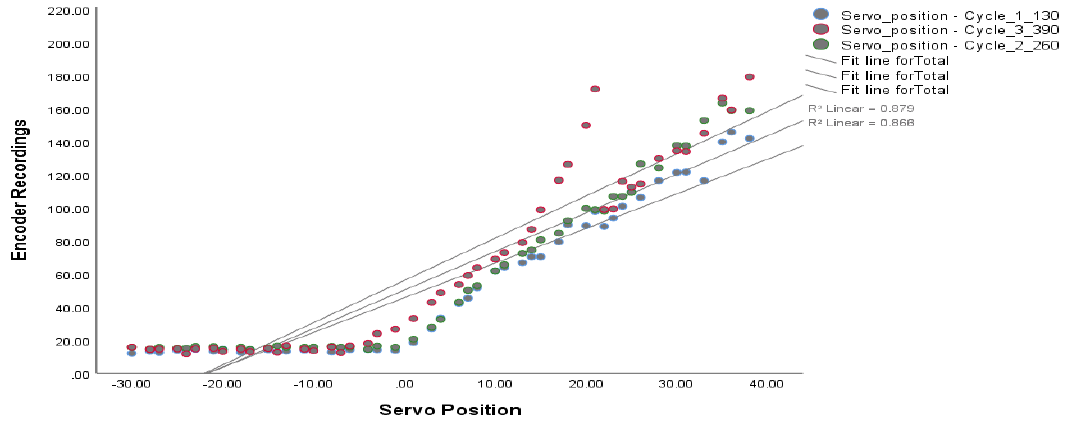
Figure 9. Simple scatter with fit line of encoder recordings against commanded servo